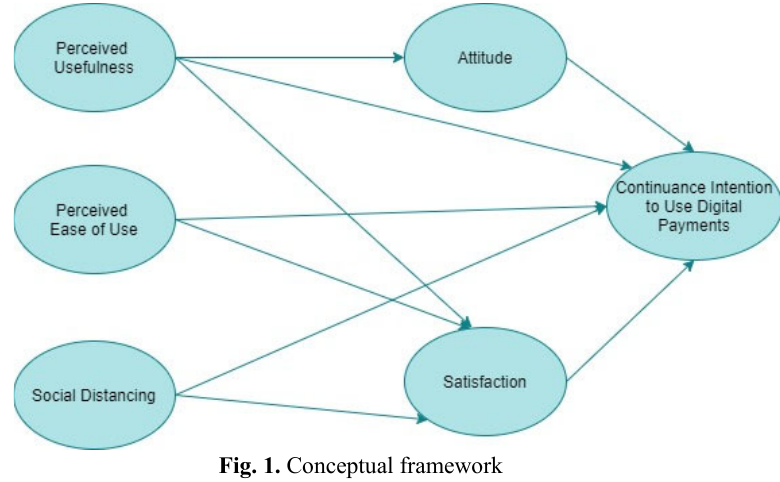
Fig. 1. Conceptual